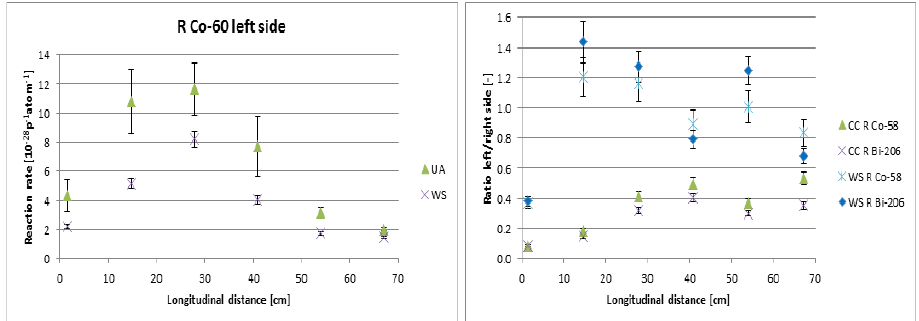
Figure 4. Experimental reaction rates of 60 Co production for UA and WS experiments for samples on the left side and l eft/right side, experimental reaction rate ratios for CC and WS experiments